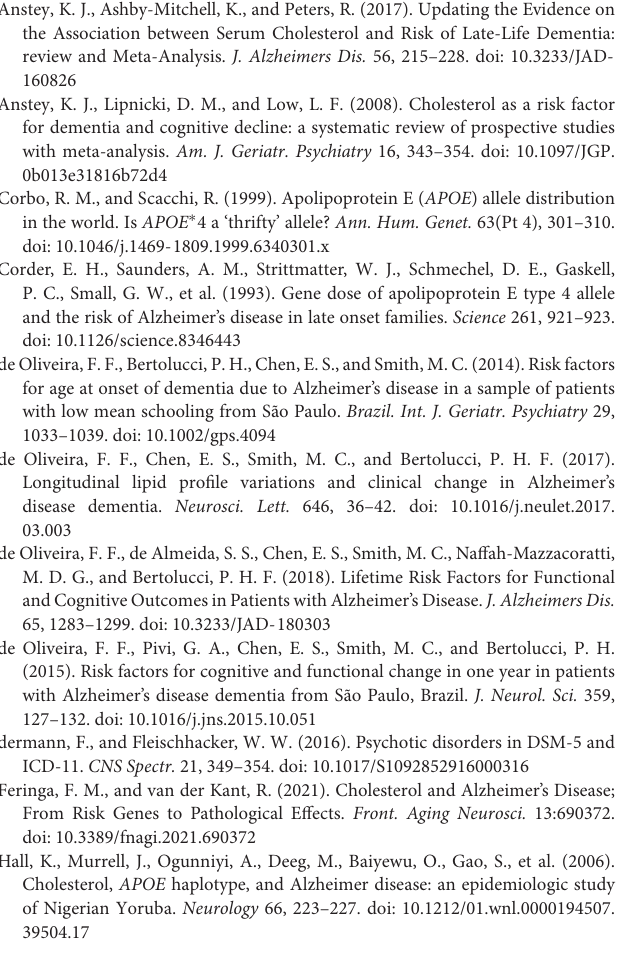
Supplementary Table 2 | Comparison of lipids between APOE ε 4 + group and APOE ε 4 − group (Adjusting for age and the stain use); Values are expressed as mean (standard deviation); AD, Alzheimer’s disease; HCs, healthy controls; Male and AD, male patients with Alzheimer’s disease; Female and AD, female patients with Alzheimer’s disease; Male and HCs, male healthy controls; Female and HCs, healthy female controls.